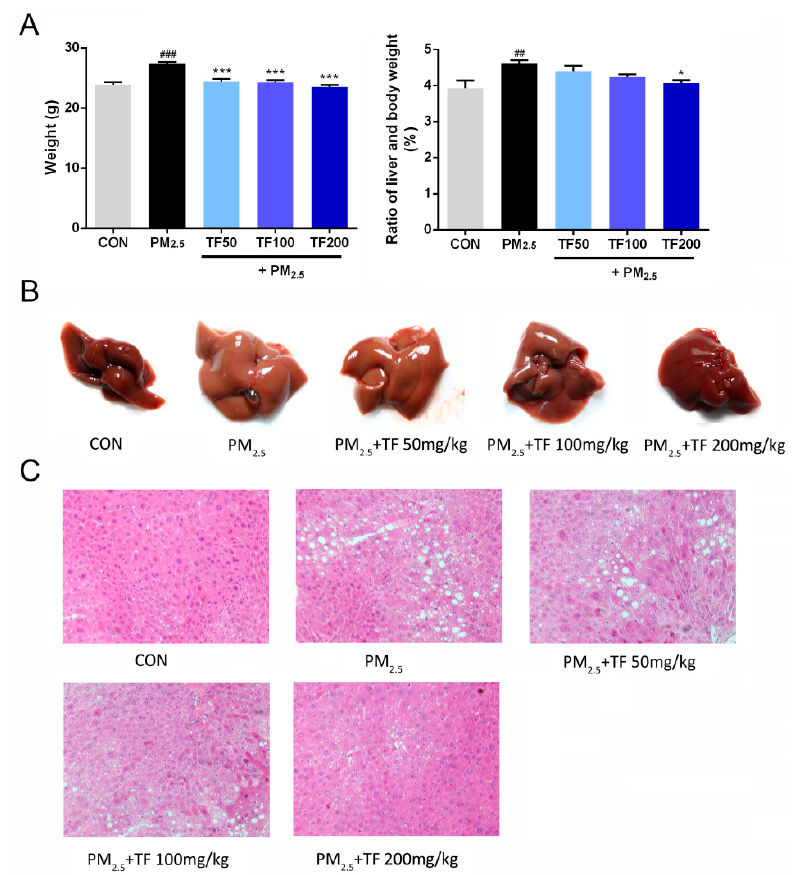
Figure 2. Body weight and ratios of liver to body weight (%) ( A ); appearance of the liver ( B ); histological analysis of liver tissues (H&E, 200× magnification) ( C ). Data are presented as mean ± SE ( n = 10). ## p < 0.01, ### p < 0.001 vs. the CON group; * p < 0.05, *** p < 0.001 vs. the PM 2.5